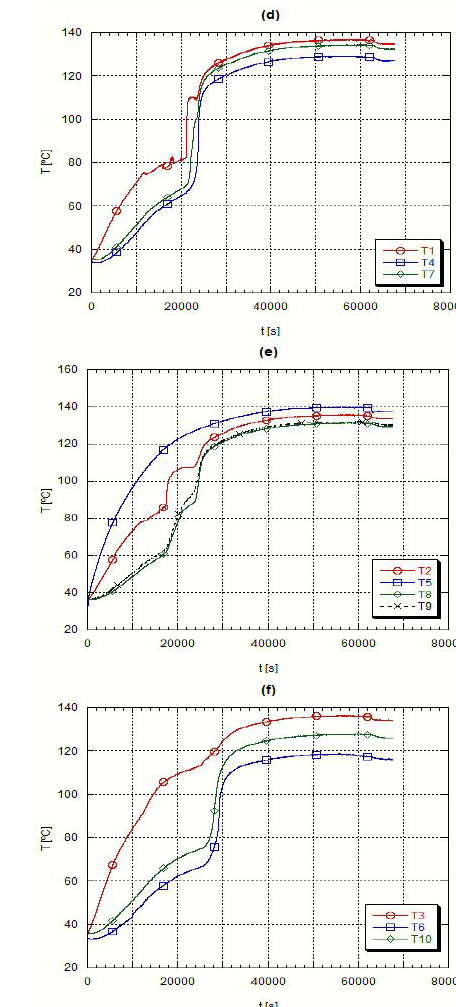
Figure 5. Radial evolution of phase change materials temperature during fusion. Plots ( a – c )—H105; Plots ( d – f